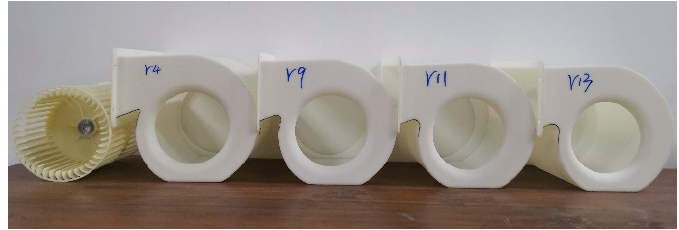
Figure 4. Impeller and volute with tongue radius r = 4 mm, 9 mm, 11 mm and 13 mm.